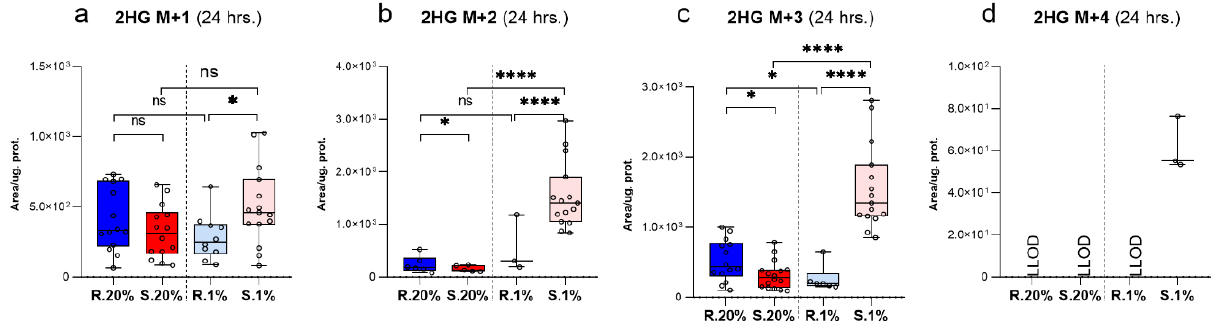
Figure 3. The intracellular levels of different mass isotopologues of 2HG . ( a ) 2HG M+1; ( b ) 2HG M+2; ( c ), 2HG M+3; and ( d ) 2HG M+4 in the Spalax and rat cells under normoxia and hypoxia after they were cultivated for one day under normoxia